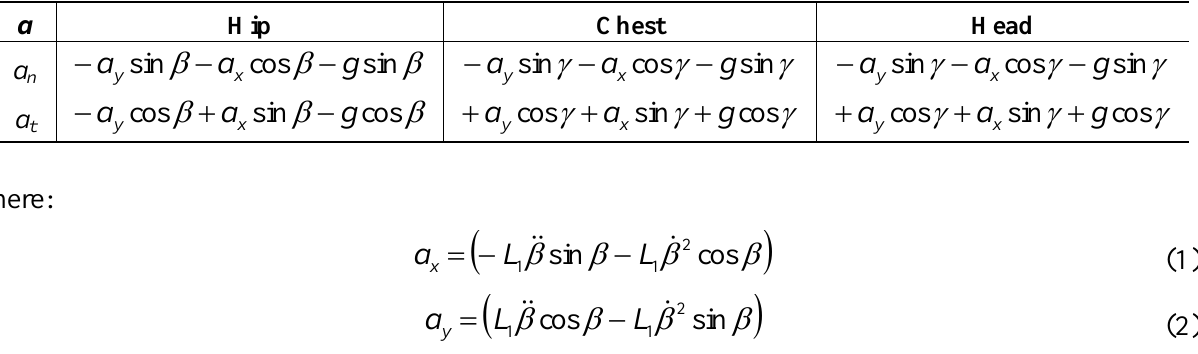
Table 1. Normal and tangential accelerations equations for hip, chest and head positions.